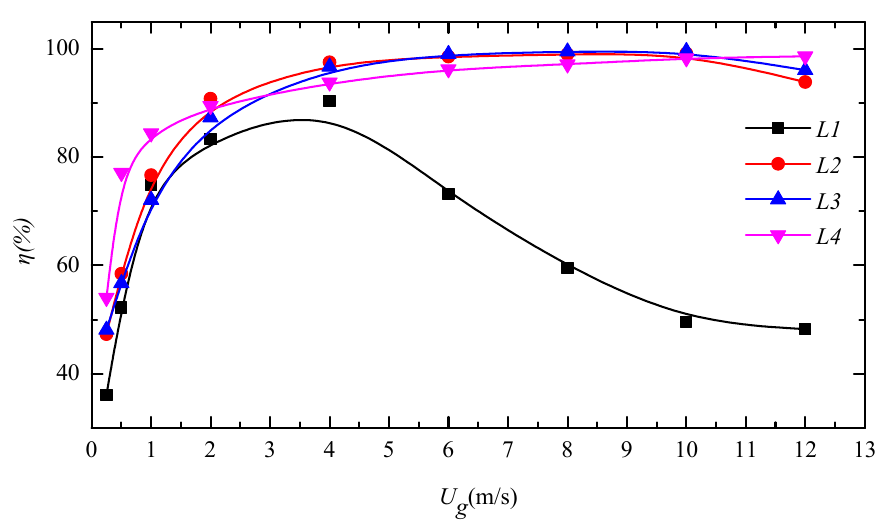
Figure 15. Numerical results of separation efficiency inside demisters with different wavelengths.